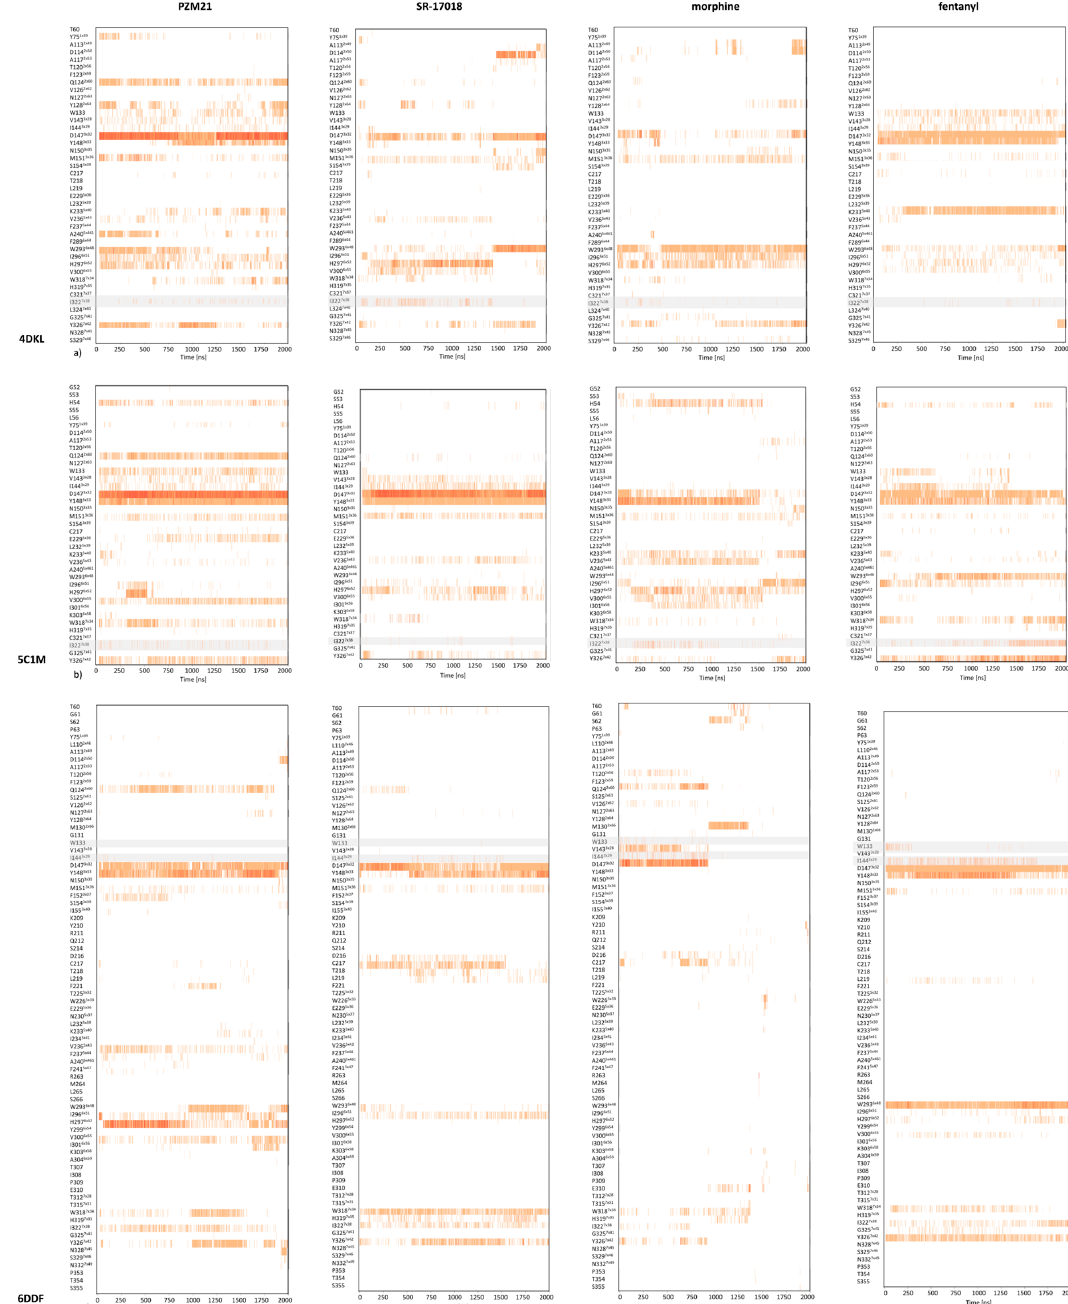
Figure 6. Ligand–protein contacts occurring during molecular dynamics simulations with ( a ) 4DKL, ( b ) 5C1M, and ( c ) 6DDF µ opioid receptor crystal structure. Positions for which the highest correlation between the output of the tail flick experiment and interaction frequency were indicated are